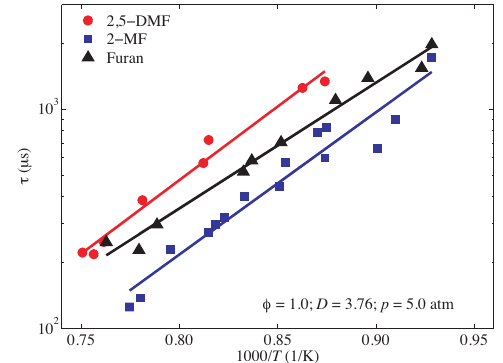
Figure 8. Comparative ignition behavior of furan, 2-MF and 2,5-DMF as shown in Eldeeb and Akih-Kumgeh [24] at a pressure of 5.0 atm, stoichiometric conditions and an Ar/O